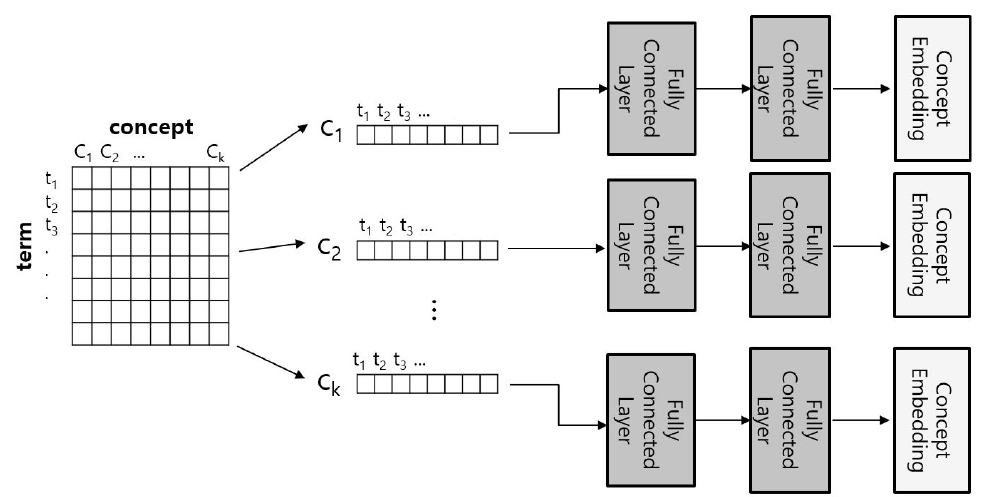
Figure 5. The concept embedding